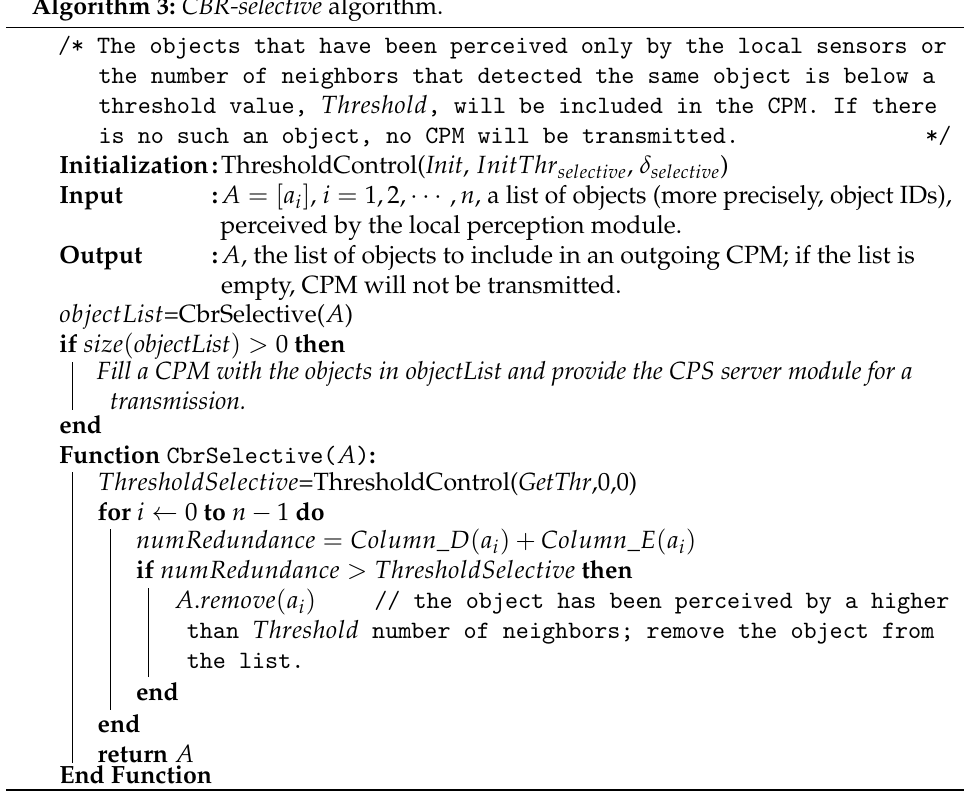
Algorithm 3: CBR-selective